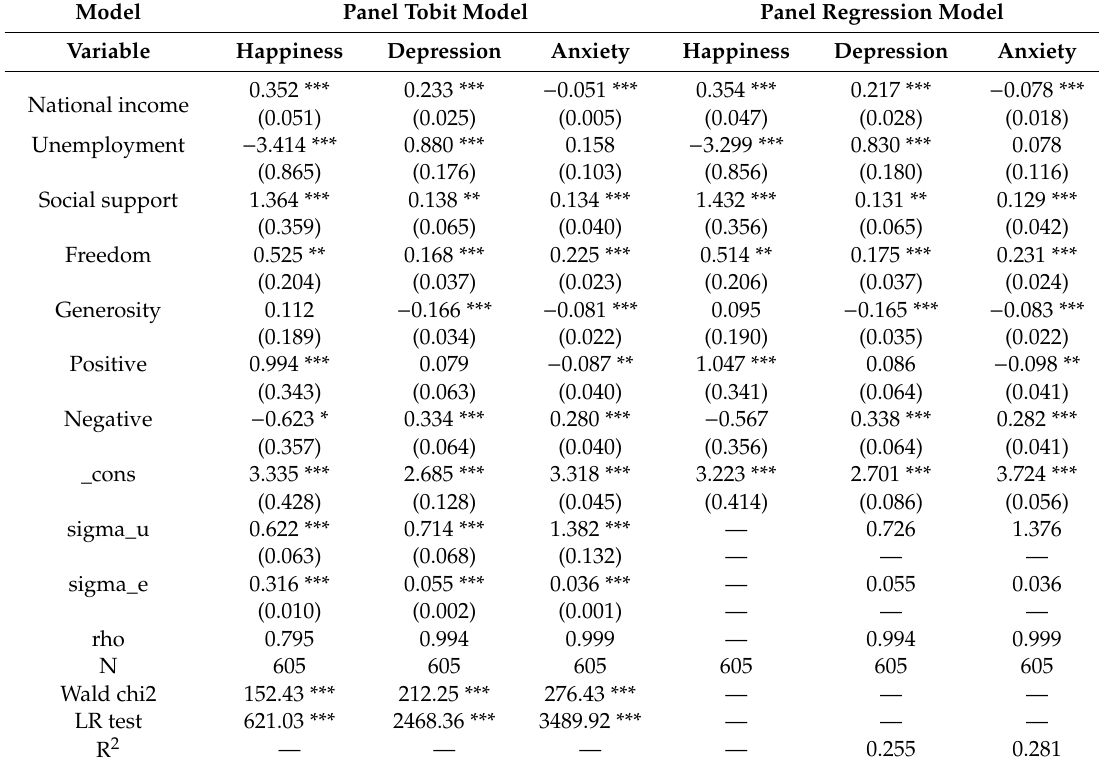
Table 4. The results of impact of national income on di ff erent types of mental